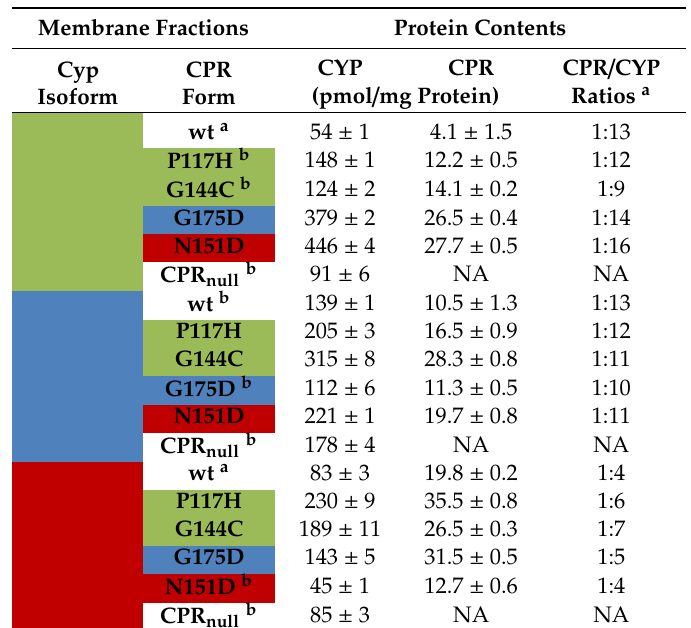
Table 1. Cytochromes P450 (CYP) and cytochrome P450 oxidoreductase (CPR) contents of bacterial CPR / CYP co-expression system (BTC) membrane